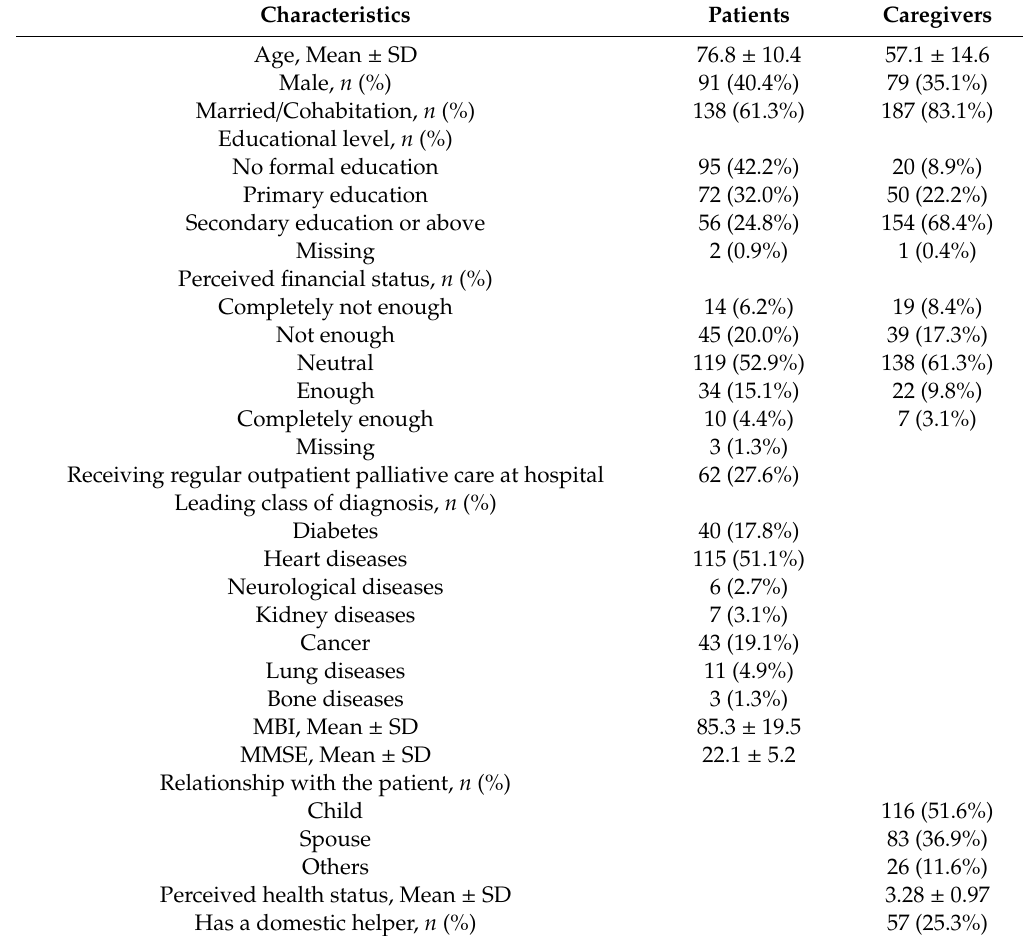
Table 1. Characteristics of primary caregivers ( n = 225).